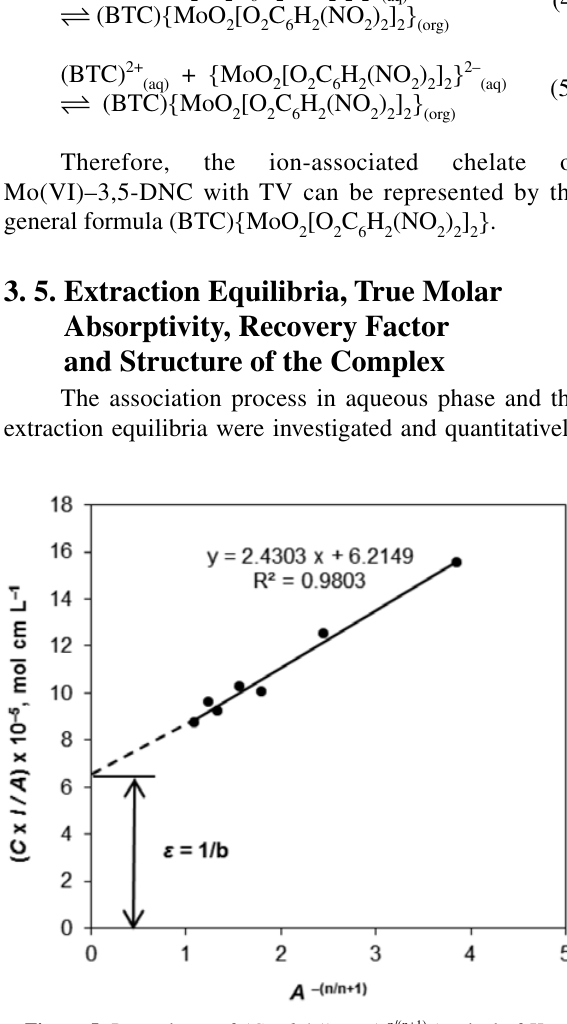
Figure 5. Dependency of ( C × l / A ) on A –n/(n+1) (method of Ko- mar–Tolmachev)